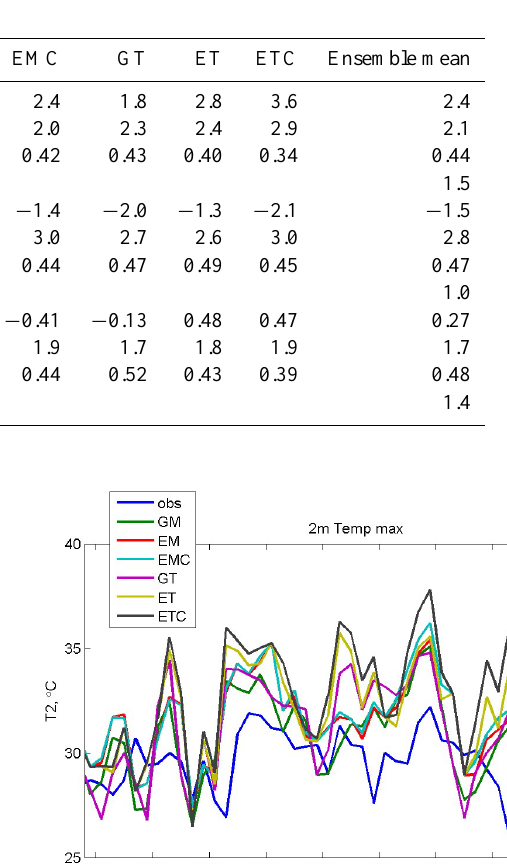
Table 3. Comparison statistics of near-surface (2m) temperature for 28 Climate Reference Network sites. Model results are from the nearest grid point to each site. Sign of biases is model–measurement.